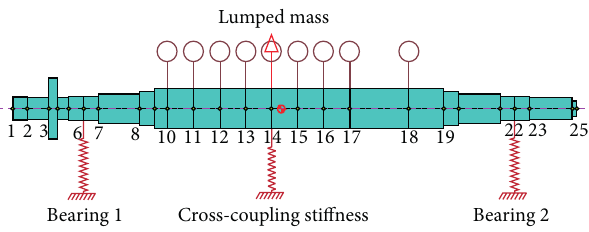
Figure 2: Rotordynamic model of a nine-stage centrifugal compres- sor model.